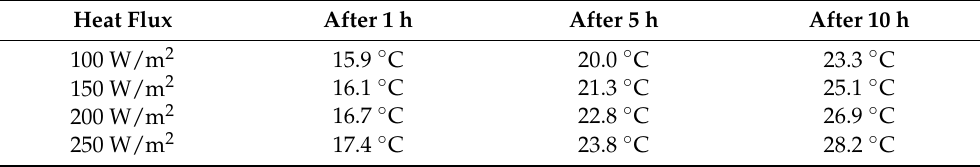
Table 2. The average temperature on the surface of the wall for CW02.